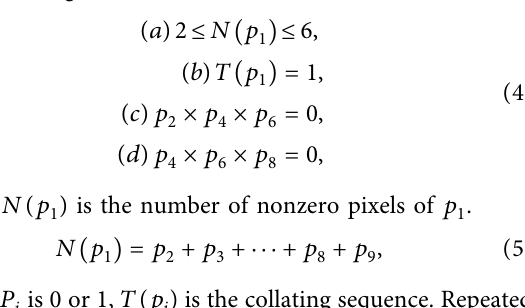
algorithm based on deleting region boundary points to